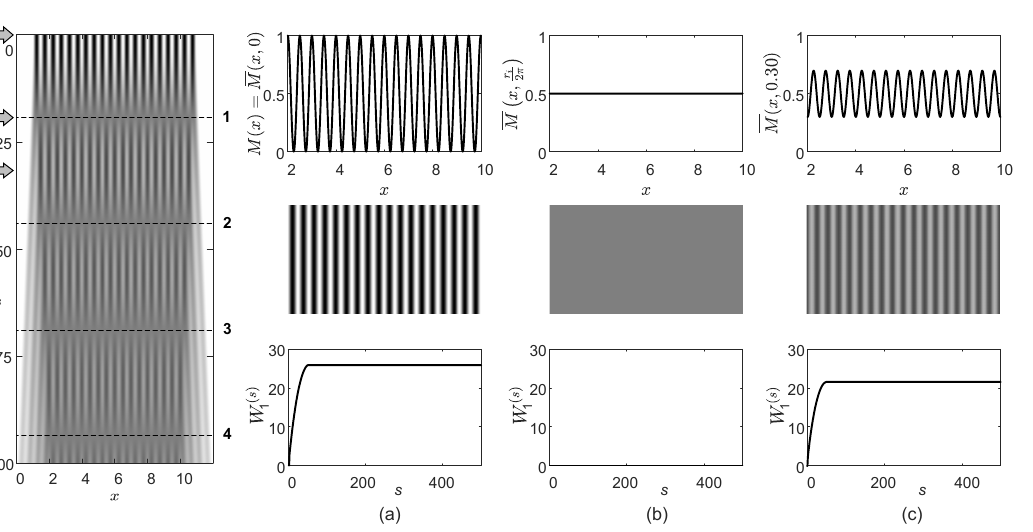
Figure 1. Optical time-averaging effects induced by harmonic oscillations on a periodic moiré grating ( λ = 0.5). Time-averaged moiré gratings are depicted in the left panel at increasing values of amplitude a (the numbering on the right boundary of the panel corresponds to the consecutive order of the time-averaged fringe). Time-averaged moiré gratings, their optical representations, and their ( s ) Wada indexes W are shown at a = 0 (panel ( a )), a = λ r i (panel ( b )), and a = 0.3 (panel ( c )). 2 π 1 The panels representing Wada indexes in Figure 1 are constructed in such a way that the horizontal axis represents the length of the 1D observation window s . In other